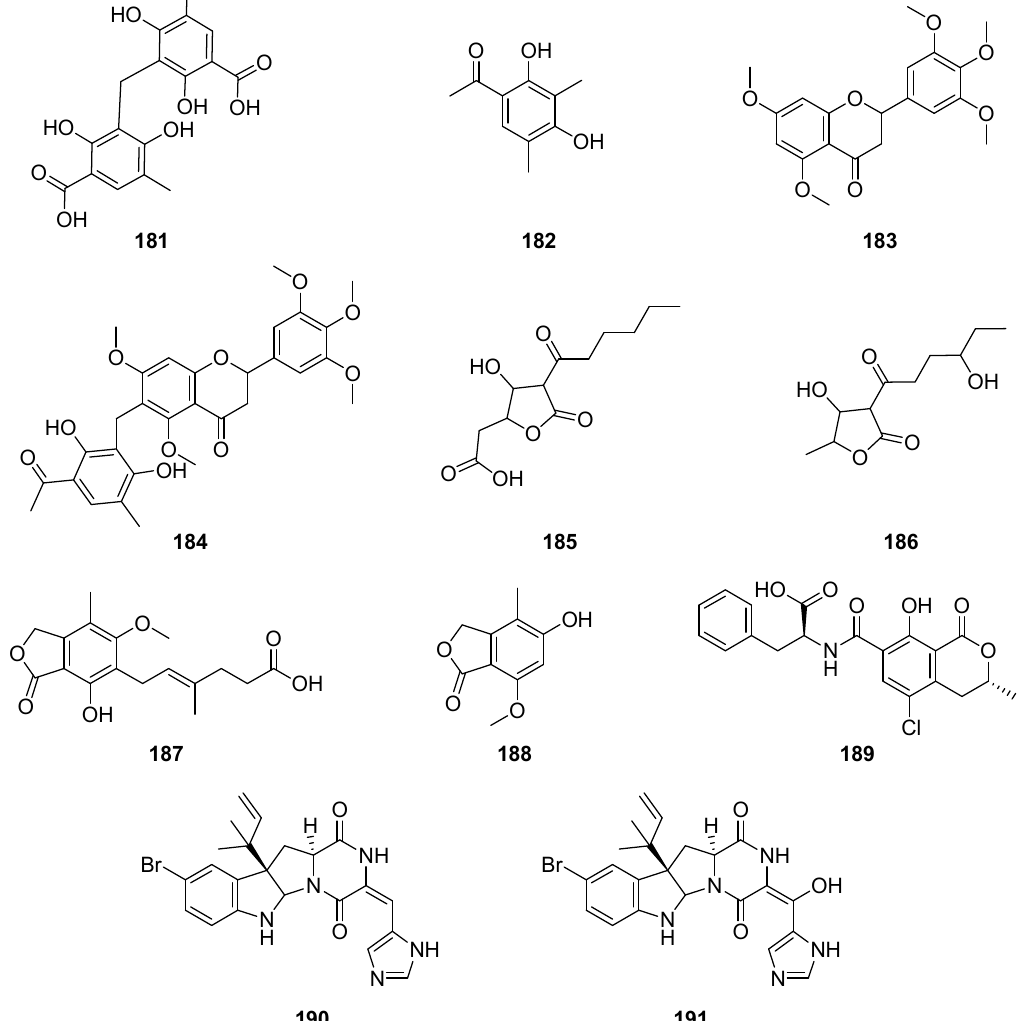
Figure 14. Compounds extracted from endophytic fungi, P. griseoroseum, P. crustosum and P. chrysogenum obtained from C. arabica.